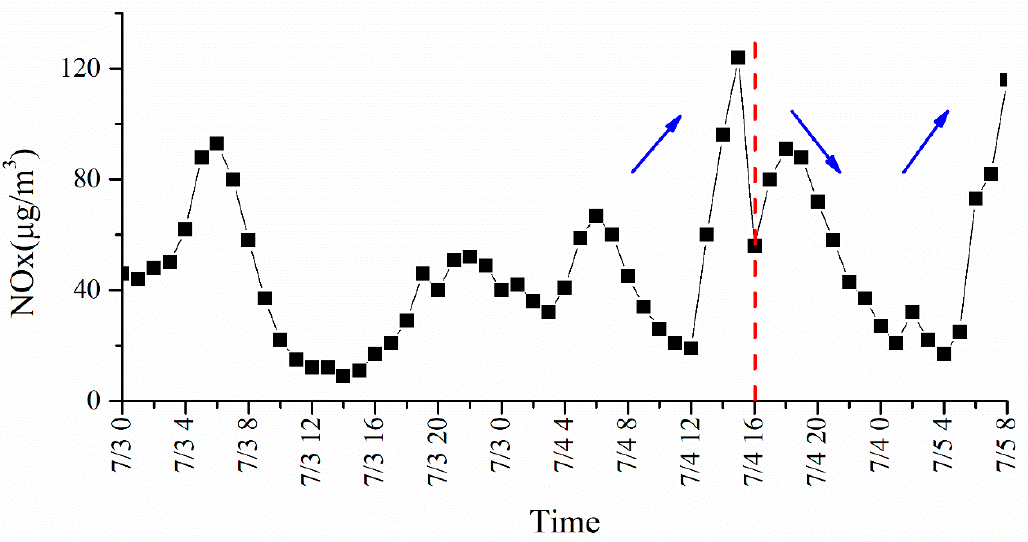
Figure 12. Time series of NO x concentration at Xuhui site on 3–5 July 2011. Red dash line: Cold front passing time.